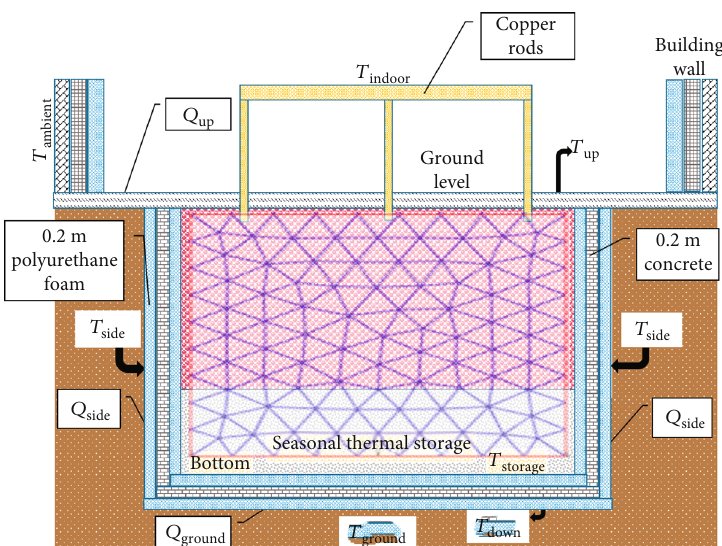
Figure 6: STES environmental variable diagram. ∗ T : ground temperature; T : STES surface temperature; T ground side : STES temperature; T : STES upper surface temperature; T : hotel ’ s indoor-air temperature. Temperature was temperature; T storage up indoor measured by ° C; all Q symbols are illustrating the heat loss according to their relevant